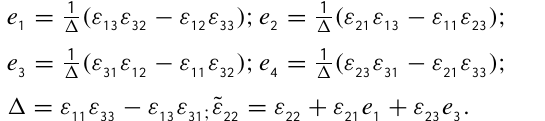
Fig.2. Part (a). Vertical dependence of the concentration of electrons used in the simulations. Curve 1 is at the daytime (normal solar activity), curve 2 is at the daytime (maximum solar activity), curve 3 is at the daytime (minimal solar activity), curve 4 is at the nighttime. Part (b). Vertical dependencies of electron (curve 1) and ion (curve 2) collision frequencies used in simulations.